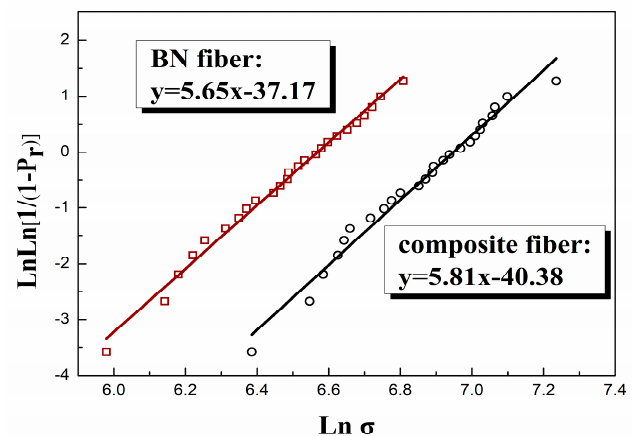
Figure 7. Weibull plot of failure strengths of these two fibers for a 25 mm gauge length: □ BN fi ber, ○ composite fiber. Table 3. Dielectric parameters of the composite fiber and other fibers.